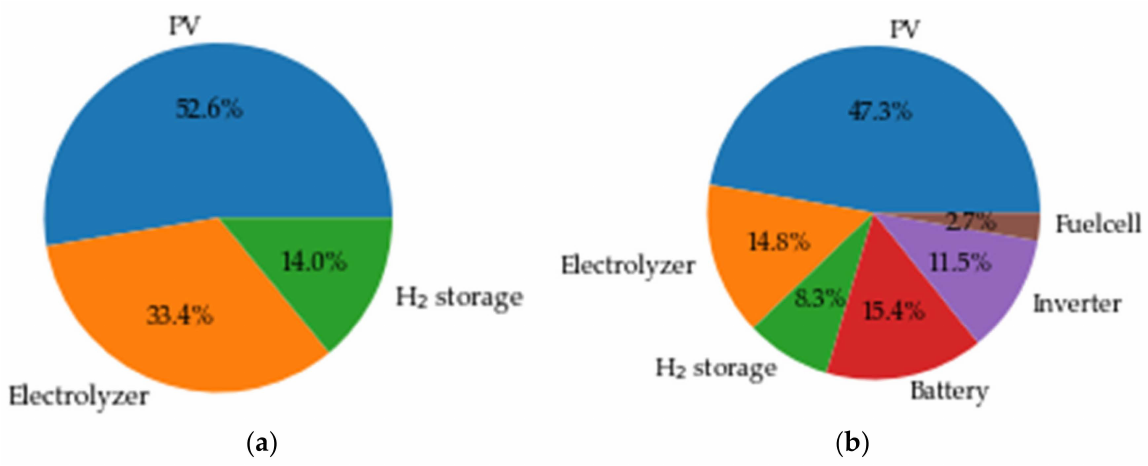
Figure A4. Share of TAC of the energy system assets for the respective optimal energy systems of ( a ) stand-alone hydrogen production and utilization via combustion, and ( b ) integrated hydrogen production and utilization via combustion and electricity